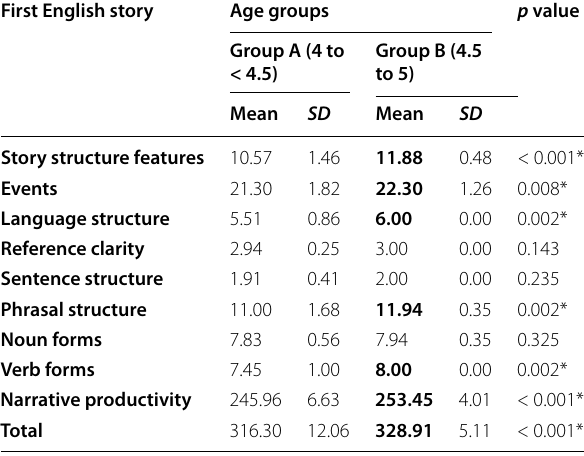
Table 7 Comparison between the two age groups regarding the scores of first English Narration Test (the doll)